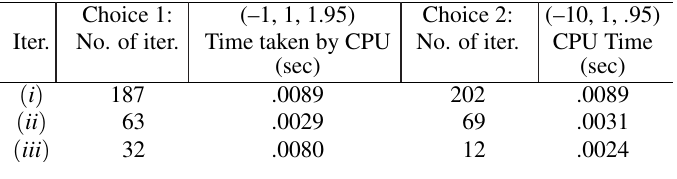
Table 1. For Choices 1 and 2, comparison for the sequences defined in Theorems 3.2–3.4 Table 2. For Choice 3, comparison for the sequences defined in Theorems 3.2–3.4